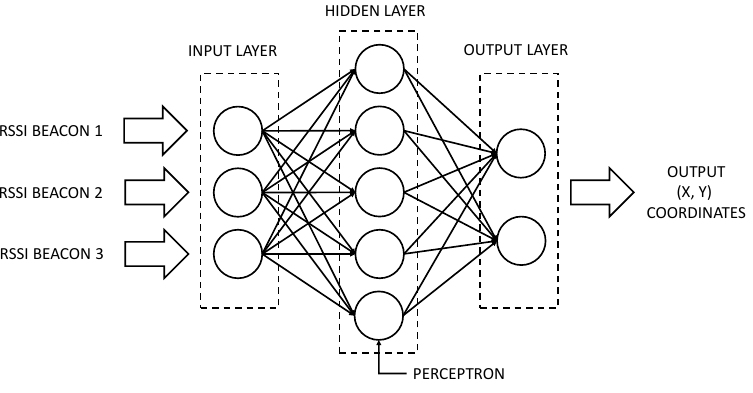
Figure 2. Multi-layer perceptron (MLP) schematic